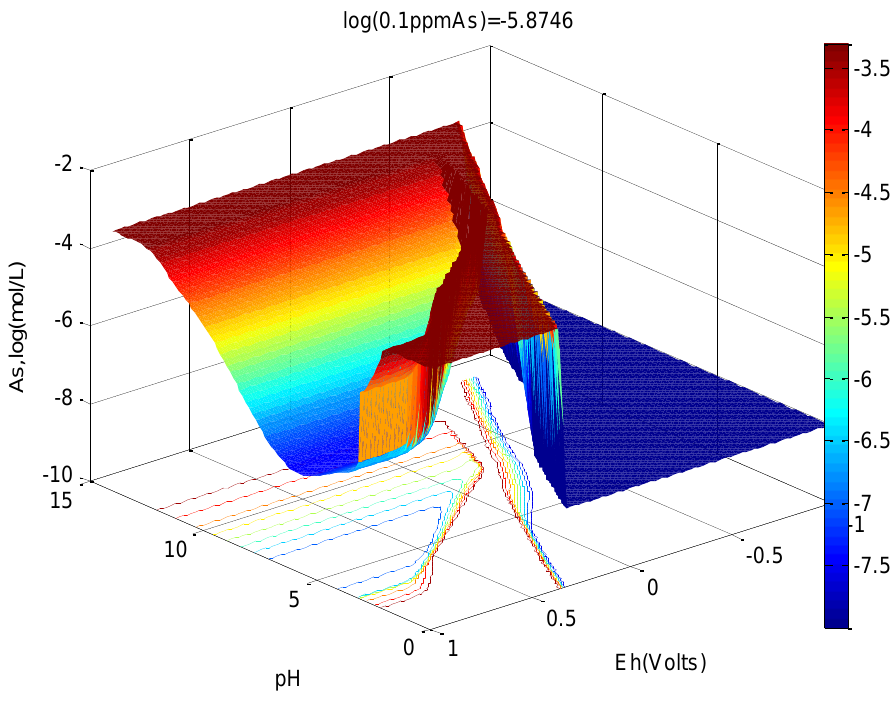
Figure 24. The Eh-pH plus solubility diagram for As–Fe–water. The valley area on the left is where the greatest adsorption of arsenic can occur.